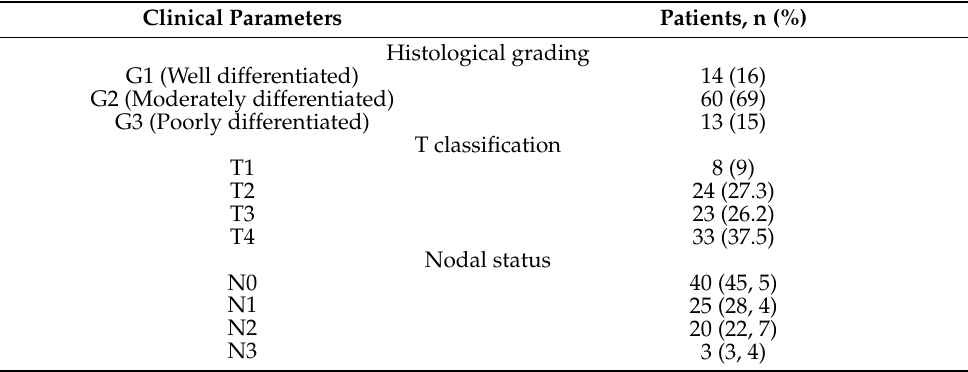
Table 1. Clinical parameters of patients with OSCC.